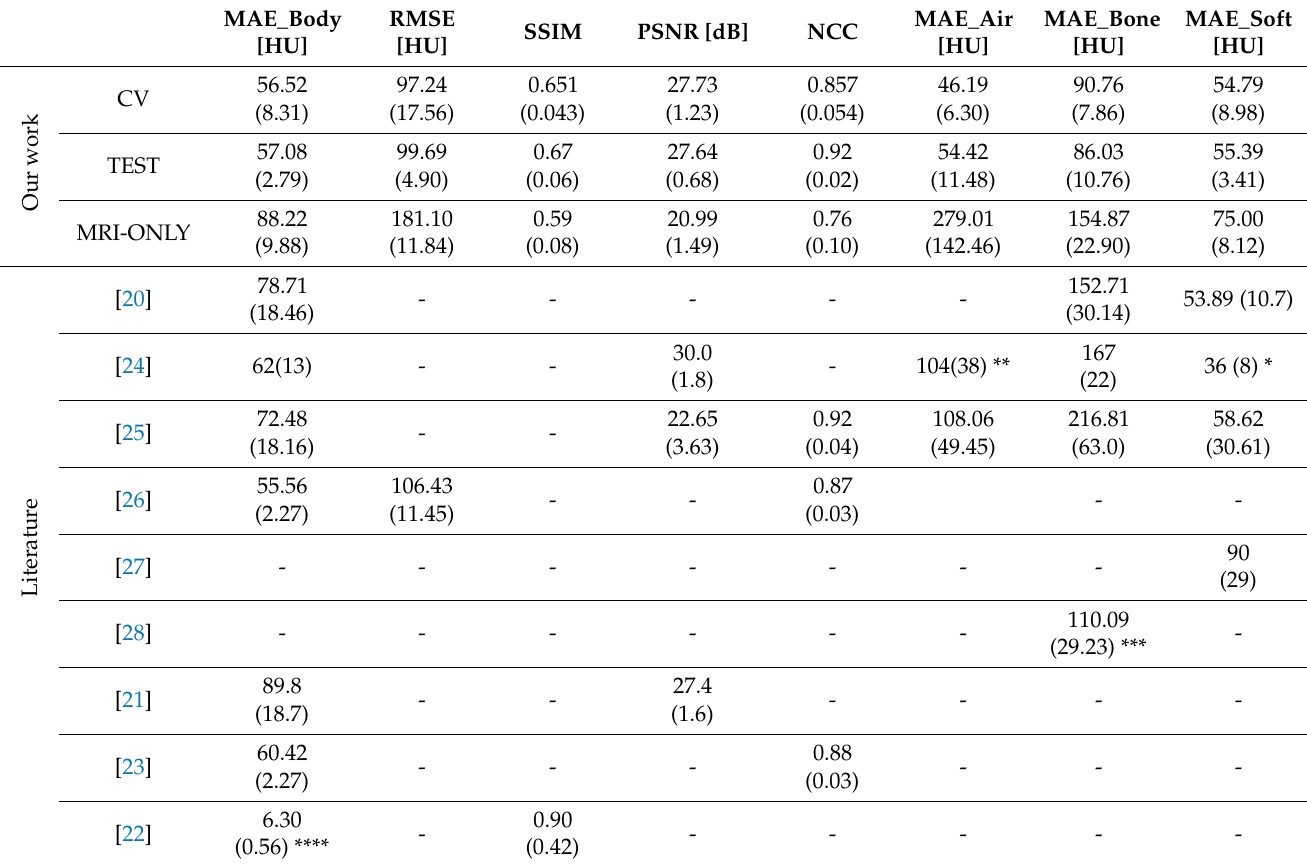
Table 2. Average results for CV, test and MRI-Only procedures, compared to the literature.